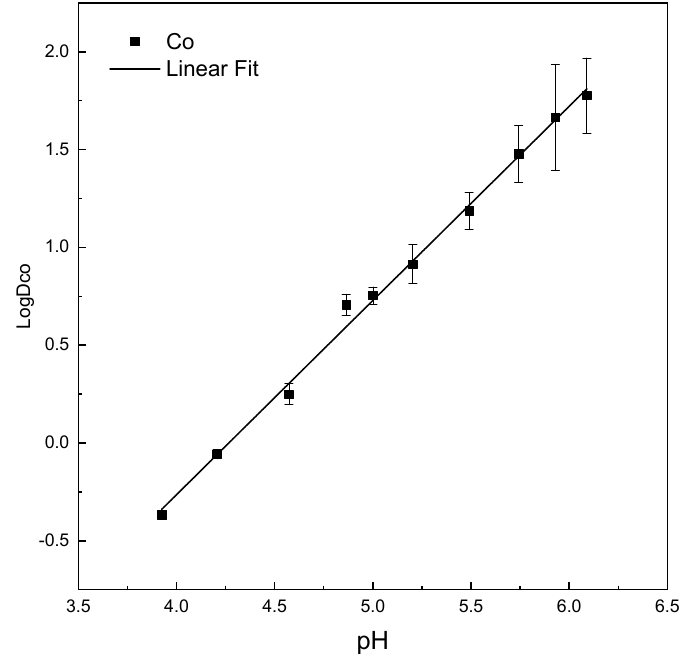
Figure 13. Correlation of extraction equilibrium pH to distribution coefficient of cobalt (Experimental